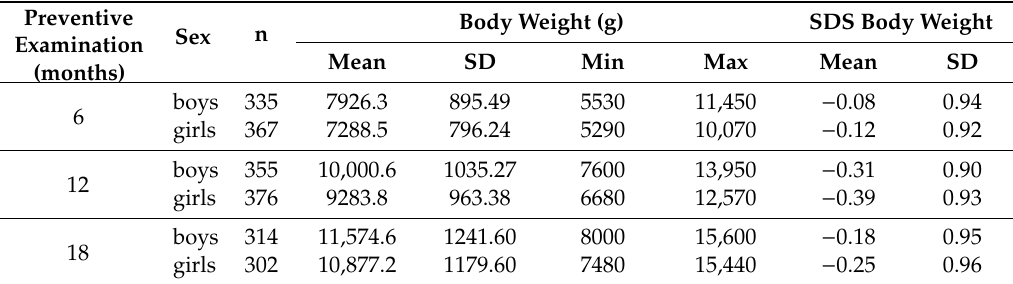
Table 3. The mean body weight and mean SDS of body weight at 6, 12, and 18 months for children breastfed for 6